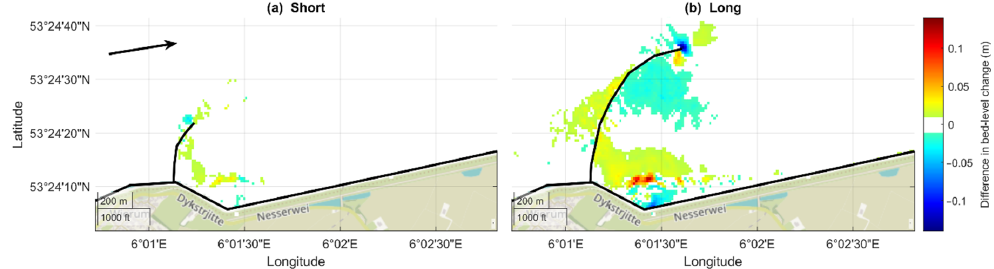
Figure 9. Difference in simulated bed level change compared to the default model for the structures ( a ) Short and ( b ) Long . Hard structures in the simulation are depicted by black lines. The arrow indicates the dominant direction of tidal flow and alongshore transport. The lee side is on the right of the structures.